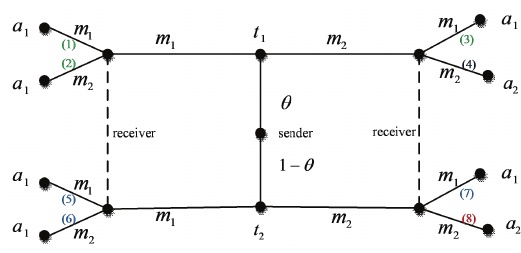
Figure 1. The signal game paths between two